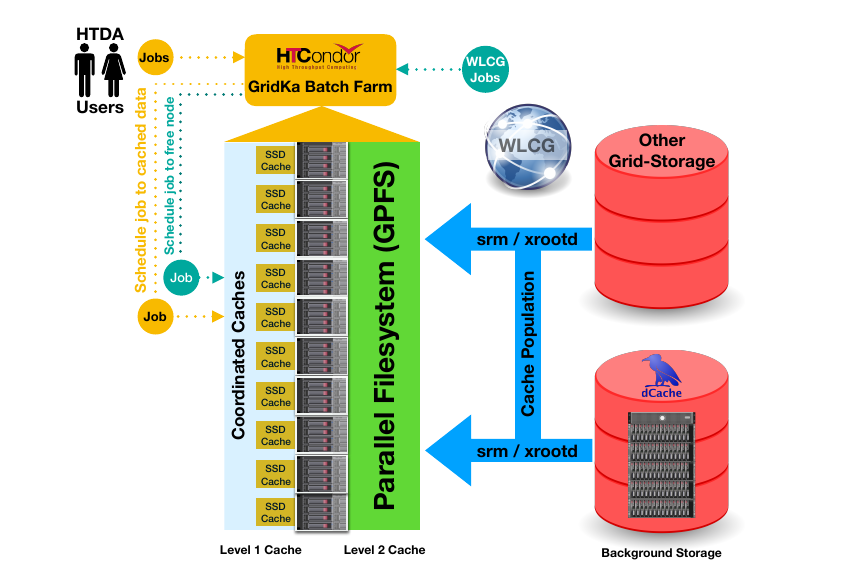
Figure 1. Design of the TOpAS cluster. The Cluster is designed to feature a hierarchical storage structure consisting of HDDs in a distributed file system and one NVMe disk for each worker node, which can be used for caching job input